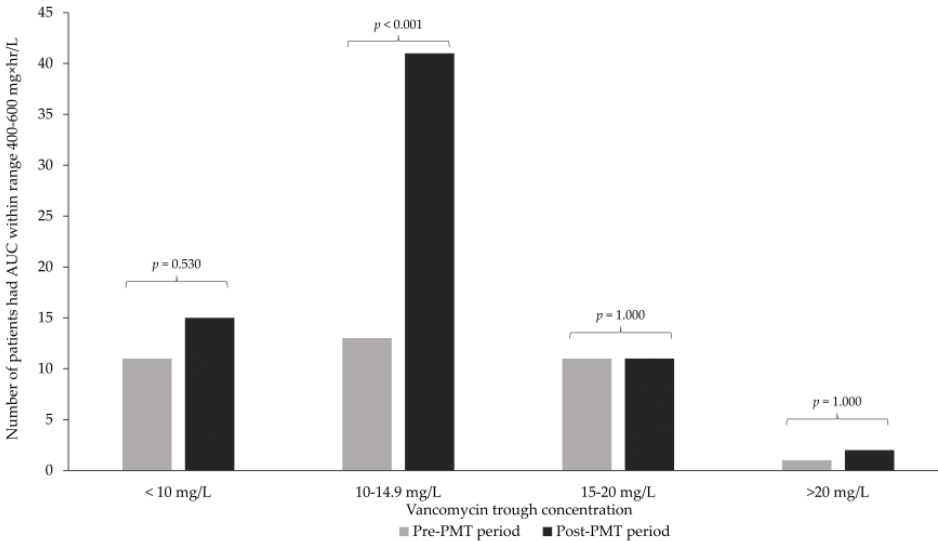
Figure 1. Distribution of the number of patients who achieved optimal vancomycin AUC and trough concentration.